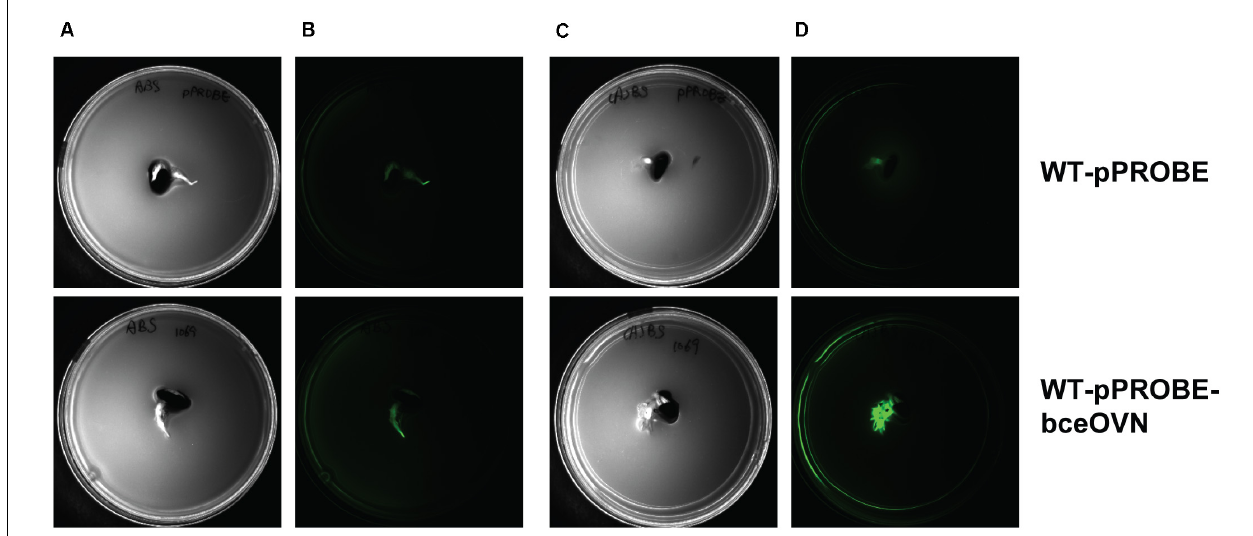
FIGURE 7 | Expression of bceN is induced by the presence of a root of a germinated seed under nitrogen starvation. Images are bottom-up view of soft agar plates in the bright field (A,C) or under a GFP filter with 500 ms exposure (B,D) . Bacteria carrying either pPROBE vector without promoter (WT-pPROBE) or GFP driven by the promoter of bceOVN operon (WT-pPROBE-bceOVN) were grown in either ABS minimal medium (A,B) or (A)BS medium with limited nitrogen source (C,D) co-incubated with a root of a germinated seed for 48 h at 30 ◦ C. GFP was induced in WT-pPROBE-bceOVN cells located in the proximity of the bean root in nitrogen-limited